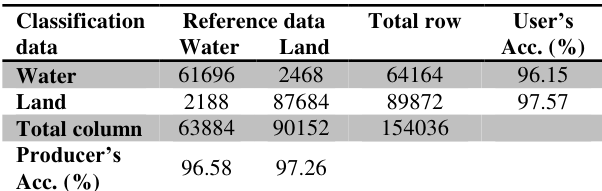
Table 4. Confusion matrix of labelled point based on NDFI G-NIR